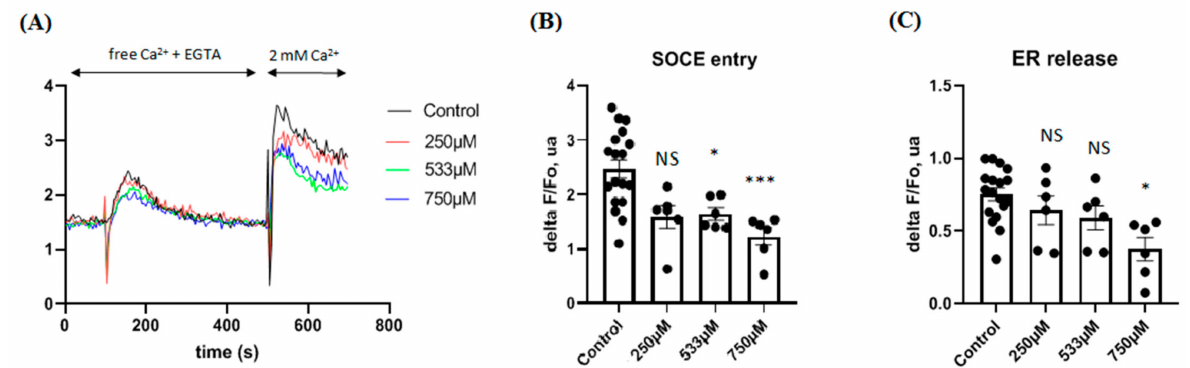
Figure 7. Effects of acute application of sAaTs-1 on the release of Ca 2+ stores and amplitude of SOCE in U87 cells. ( A ) Cells were stimulated with different doses of sAaTs-1 and have been loaded with fura-2 measuring amplitude of fluorescence ratio variation in comparison to the control condition. ( B ) SOCE entry. ( C ) ER release. Individual values and the mean value +/ − SEM of n observations ( n = 3) are presented in the different histograms. Statistical analysis and histograms were created with Prism 8 software. Kruskal-Wallis test and Dunn’s post-test were used with a p -value < 0.05 to be considered significantly different to control condition (* p < 0.05; *** p < 0.001; NS not